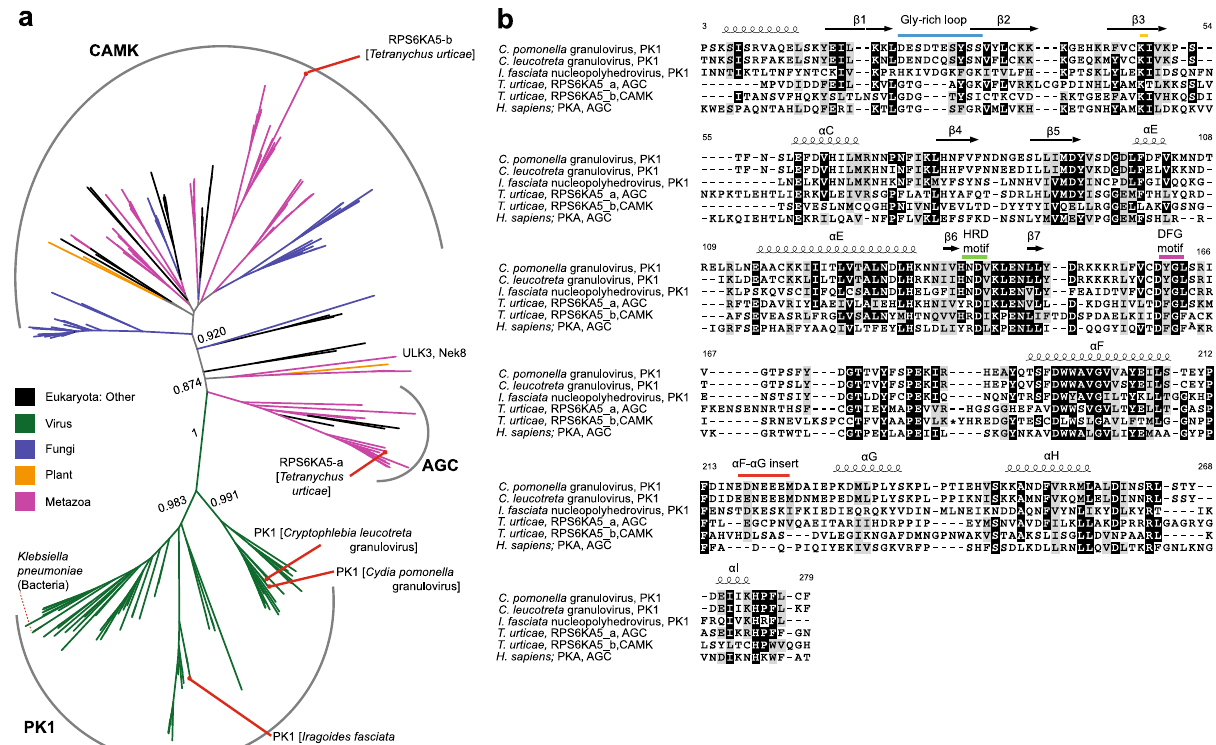
Fig. 2 Phylogenetic analysis of baculoviral PK-1. a Unrooted tree of PK-1 and closely related sequences as identi fi ed through a BLAST search. Types of organisms are differentiated by colour; major bootstrap con fi dence levels are shown and each prominent kinase family are highlighted. b Multiple sequence alignment of Cp GV PK-1 with other representative sequences on the phylogenetic tree in ( a ). The alignment was visualized using ESPript 3.0 76 with Cp GV PK-1 crystal structure as input to de fi ne the secondary structures. The black background highlights identical residues, while the grey background indicates similar residues. Residues are labelled with respect to Cp GV PK-1. The Gly-rich loop (blue), β 3-strand Lys (orange), canonical HRD (green) and DFG (pink) motif, and acidic α F – α G insert loop (red) are highlighted. Secondary structure of Cp GV PK-1 is shown above the alignment. Accession numbers for